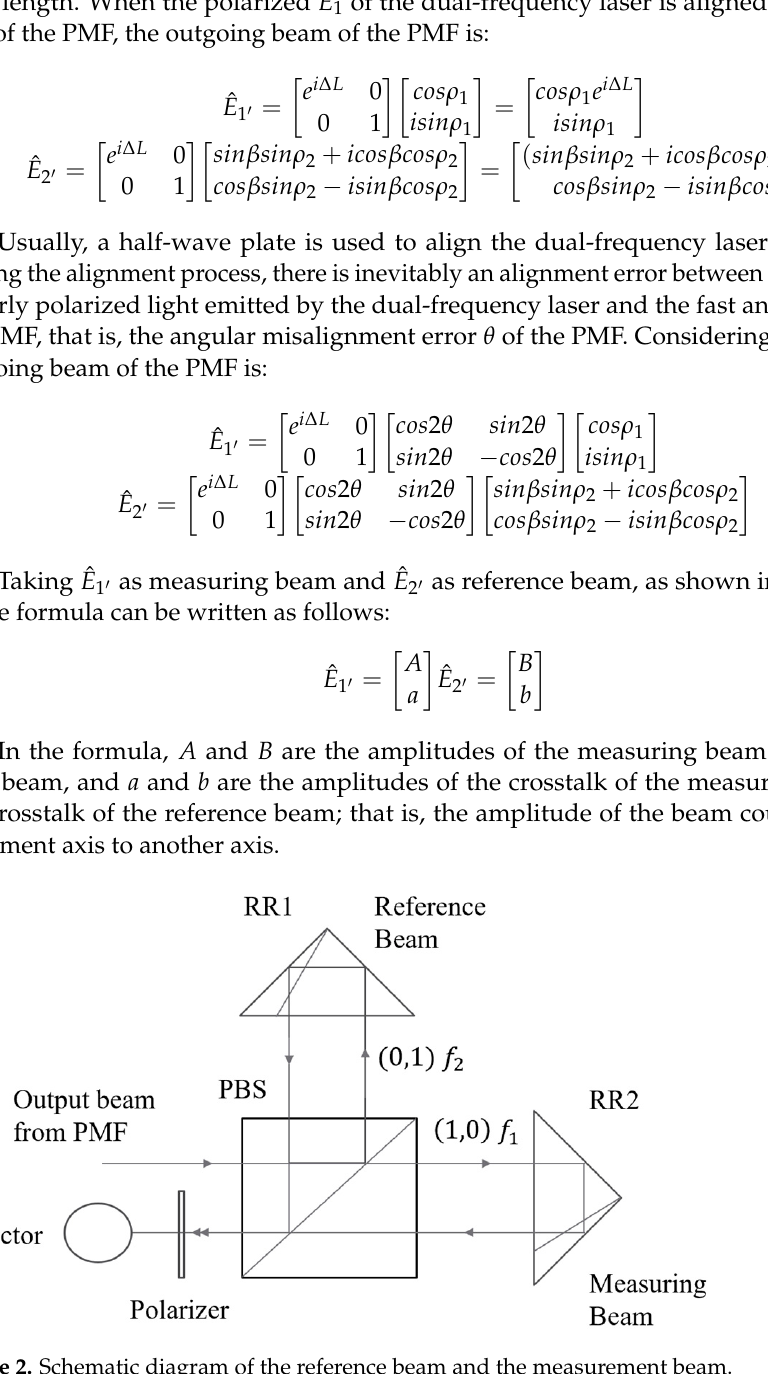
Figure 2. Schematic diagram of the reference beam and the measurement beam. After finishing, ˆ E 1 (cid:48) and ˆ E 2 (cid:48) can be written